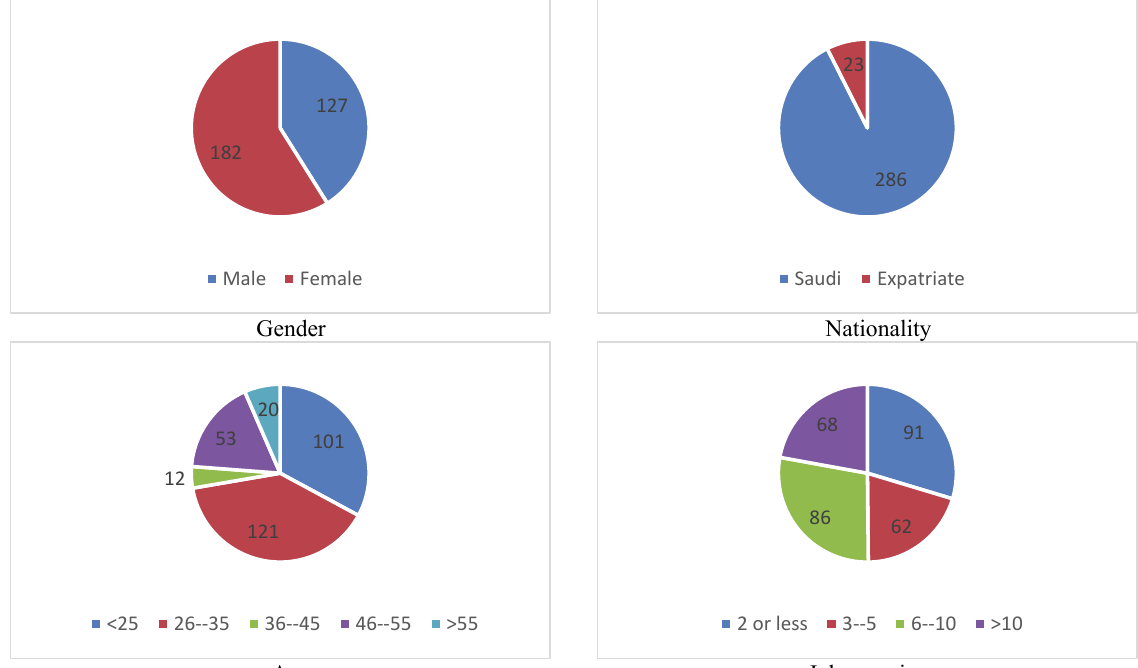
Fig. 1. Personal characteristics of the